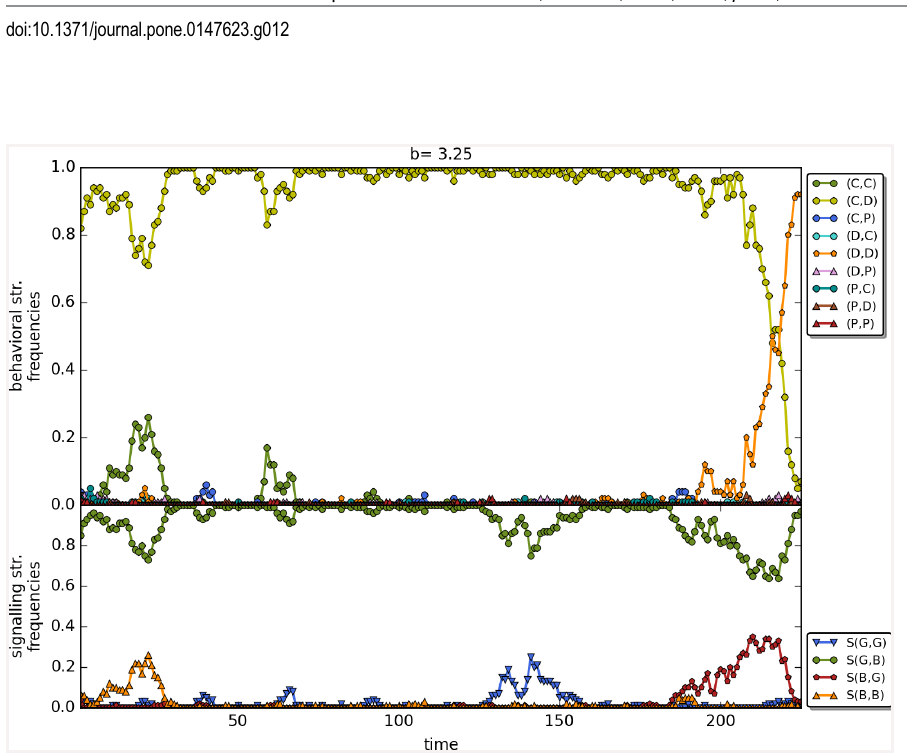
Fig 13. The timeline of an individual run using the social norm stern-judging. The figure shows the change in the frequencies of the behavioural and signalling strategies as a function of time for the social norms stern-judging. Numbers on the x axis denote 100 steps. Parameters: n = 100, b = 3.25, c = 1, α = 1, β = 4, MST =